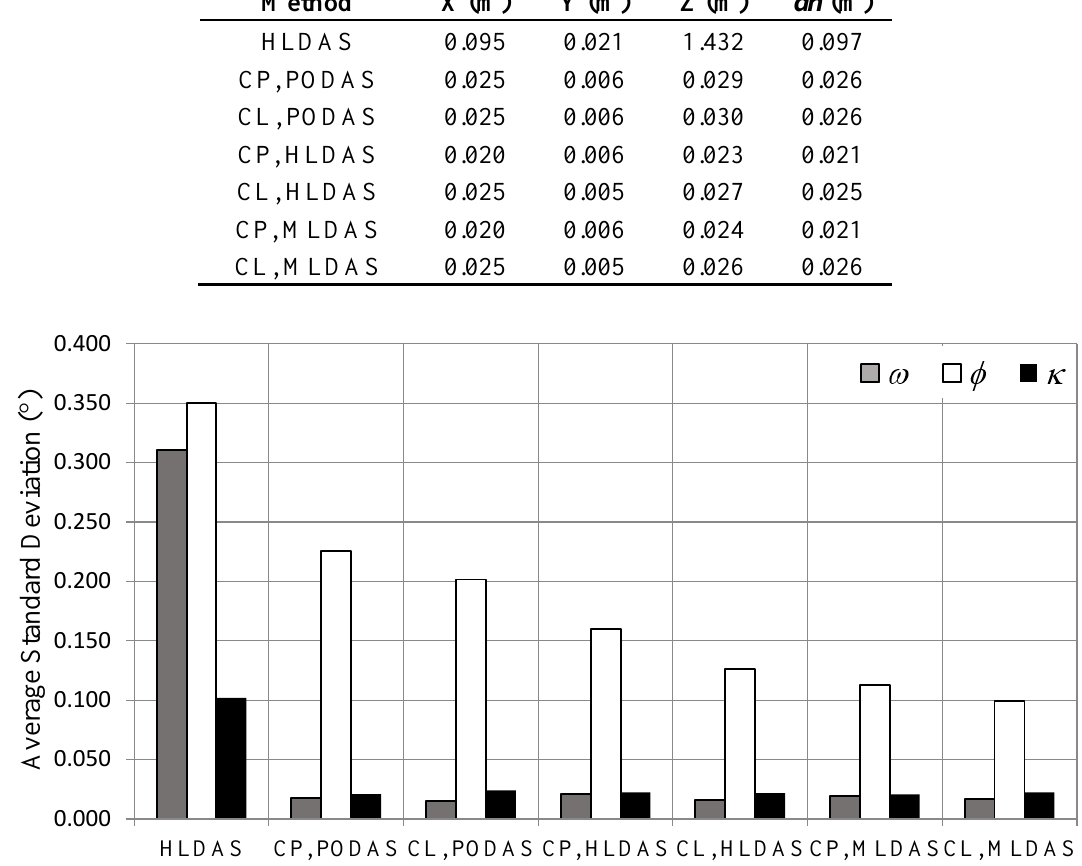
Figure 5. Average post-adjustment standard deviations for angular components of georeferencing parameters for the Site 1 dataset. Standard deviations were extracted from the a posteriori covariance matrix shown in Equation